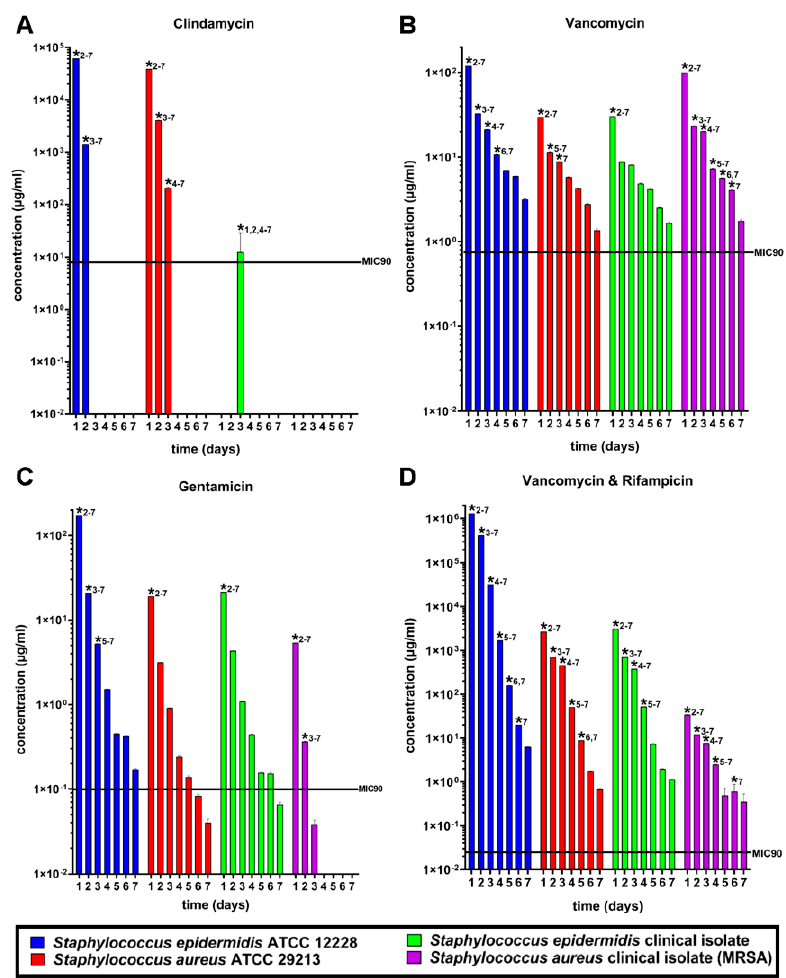
Figure 3. Antibiotic susceptibility tests for different bacterial species and strains. Four antimicrobial substances clindamycin ( A ), vancomycin ( B ), gentamycin ( C ), and vancomycin in combination with rifampicin ( D ) were tested against Staphylococcus epidermidis ATCC 12228 (blue), Staphylococcus au-